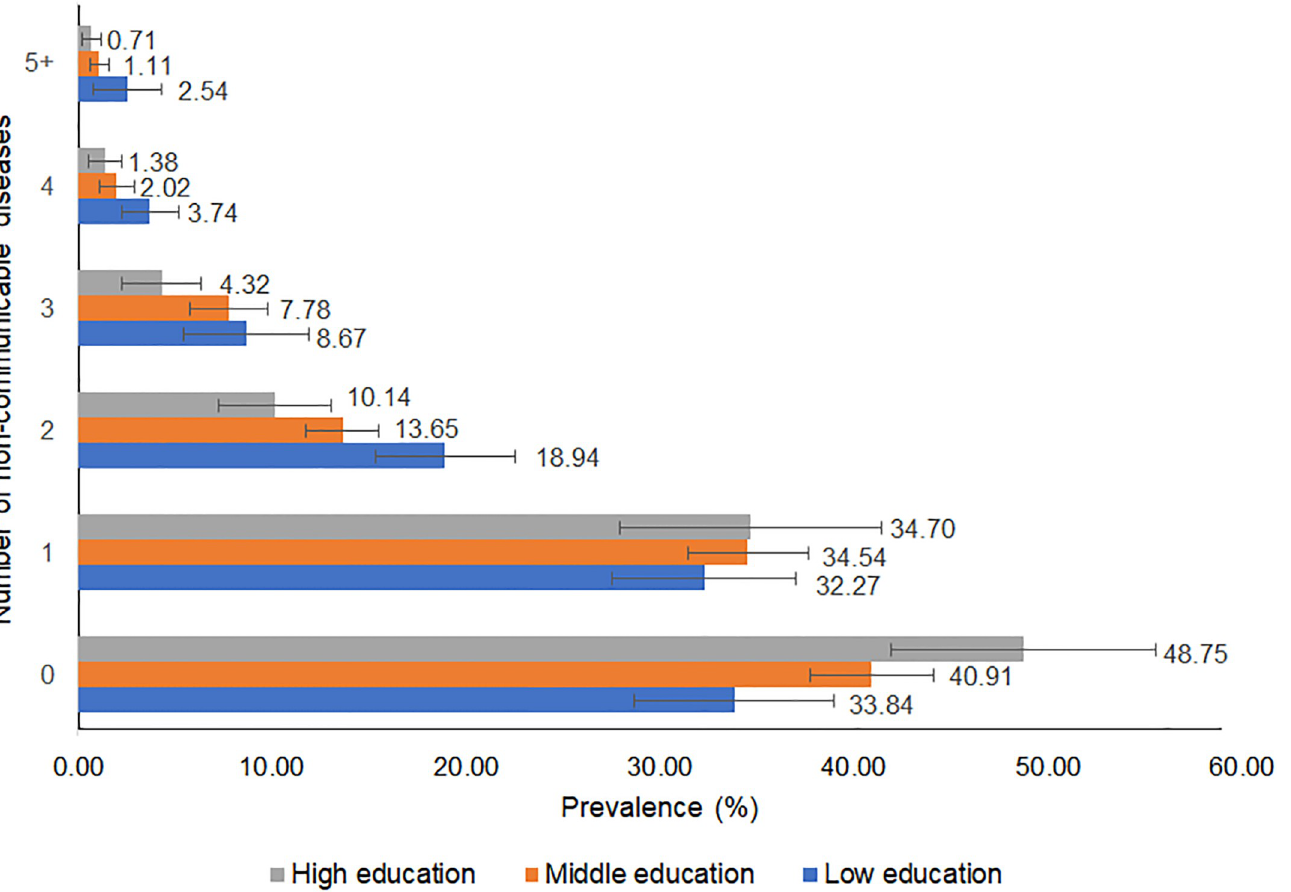
Fig 2. Prevalence of multimorbidity stratified by education level (Japan) + . + The 18 non-communicable diseases (NCDs) include heart disease, hypertension, cerebral/cerebrovascular accident, diabetes, chronic lung disease, asthma, joint disorder, depression or emotional disorder, cancer, hyperlipidaemia, liver disease, stomach ulcer or other stomach disorder, osteoporosis, eye disease, ear disorder, bladder disorder, Parkinson’s disease, dementia.